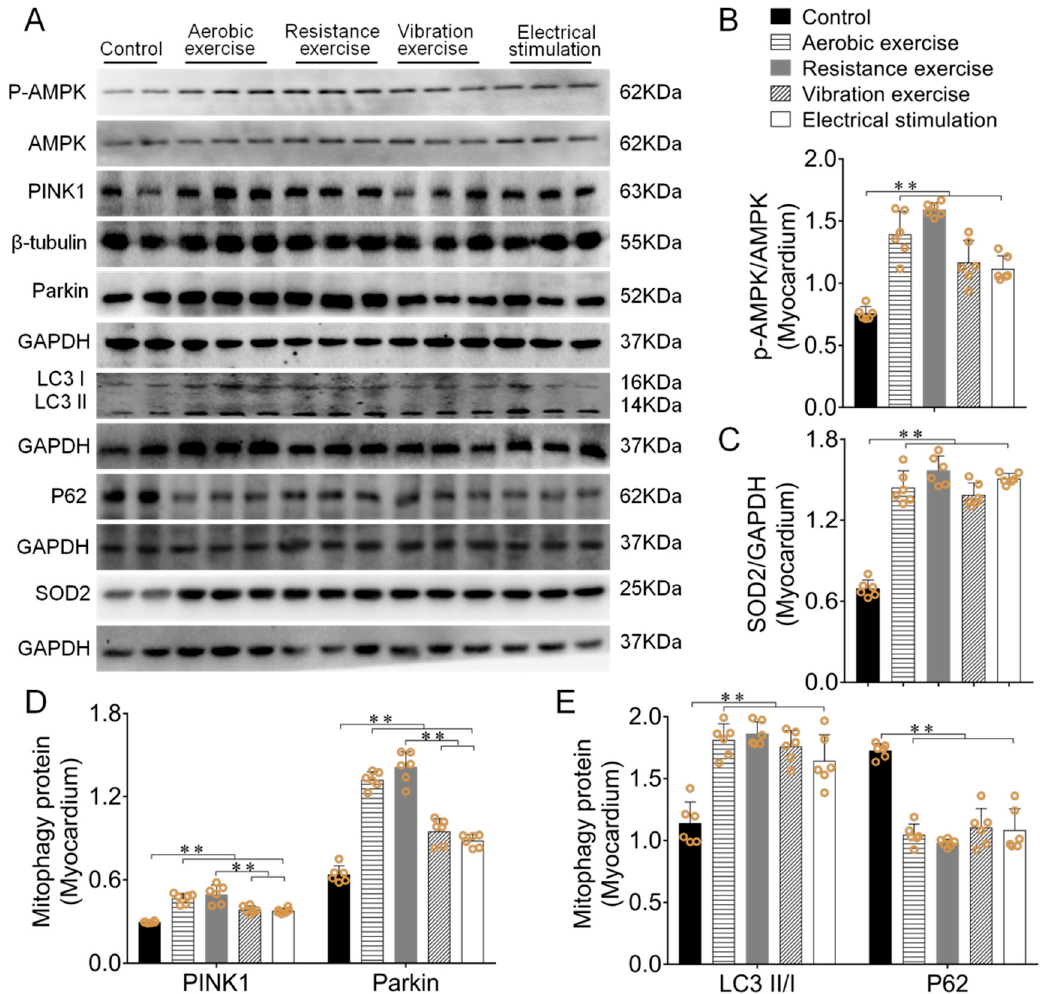
Figure 3. Different types of exercise and skeletal muscle electrical stimulation intervention activated myocardial mitophagy and enhanced antioxidant function. ( A – E ) The effect of myocardial PINK1, Parkin, P62, SOD2, LC3II/I and p-AMPK/AMPK ratio after different types of exercise and skeletal muscle electrical stimulation intervention. Data are expressed as mean ± SEM ( n = 6). ** p < 0.01. Abbreviations: AMPK: Adenosine monophosphate (AMP)-activated protein kinase; PINK1: PTEN-induced kinase 1; Parkin: E3 ubiquitin ligase parkin; LC3II/I: microtubule-associated protein light chain 3; P62: SQSTM1/p62, SOD2: superoxide dismutase